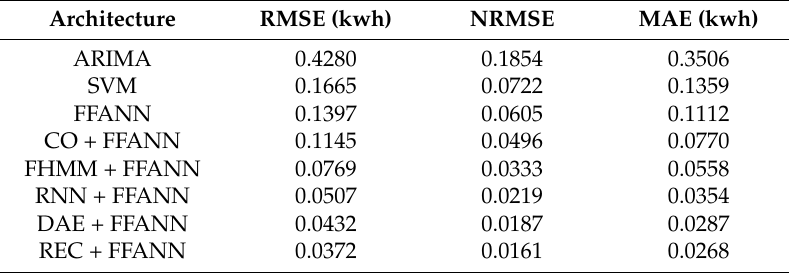
Table 3. Load forecasting performance comparison for the unseen